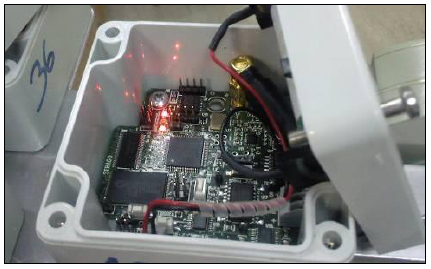
Figure 1. SMAMID Functional